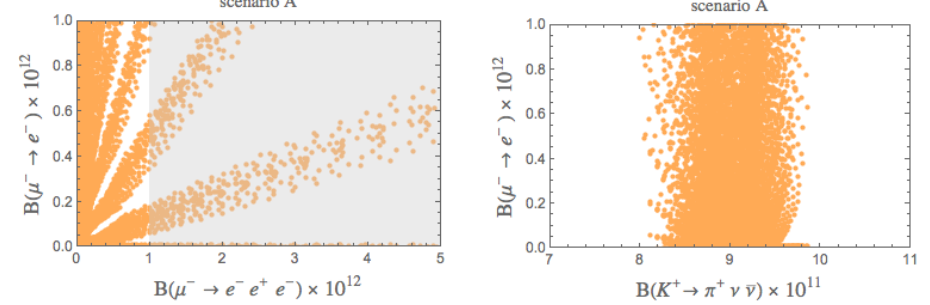
JHEP02(2020)183